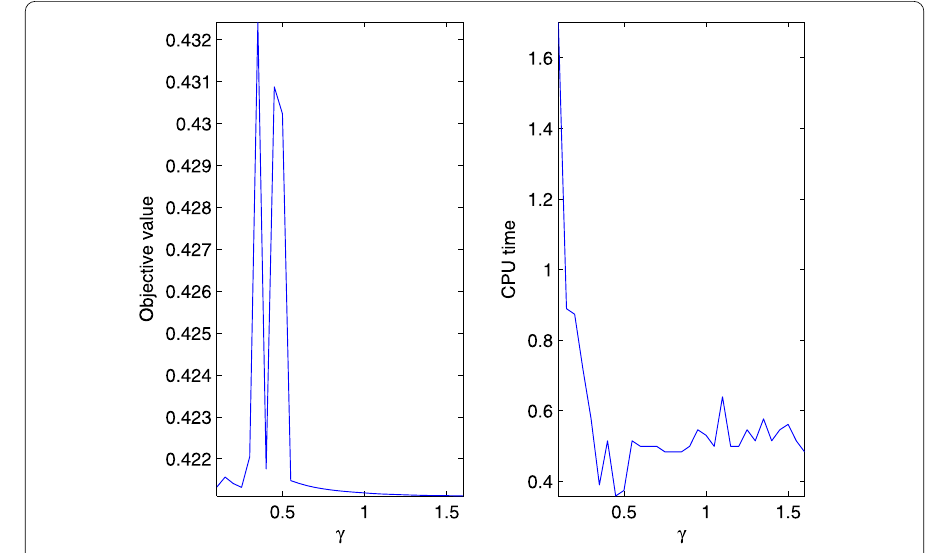
Figure 1 Objective value and CPU time with different γ .